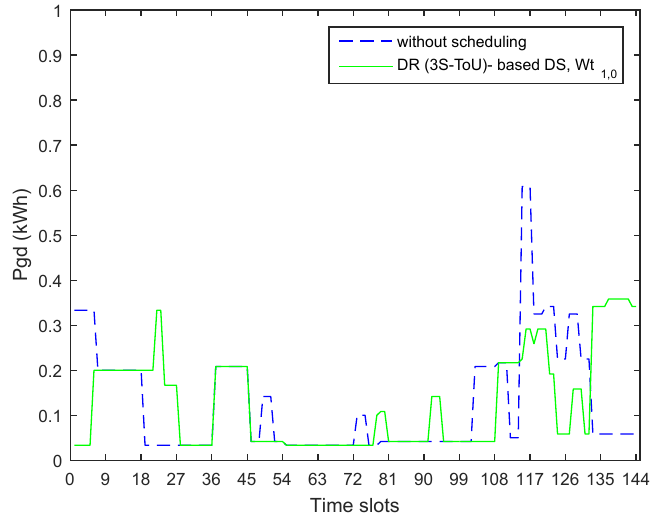
Figure 11. Load profile with maximal reduction in CE for 3S-ToUP